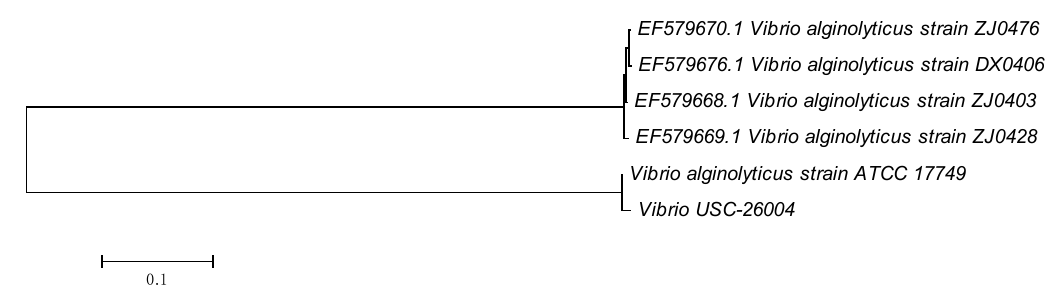
Table 1. Recorded mortality (%) of oyster ( Saccostrea glomerata ) larvae in challenge tests when exposed to different Vibrio isolates.